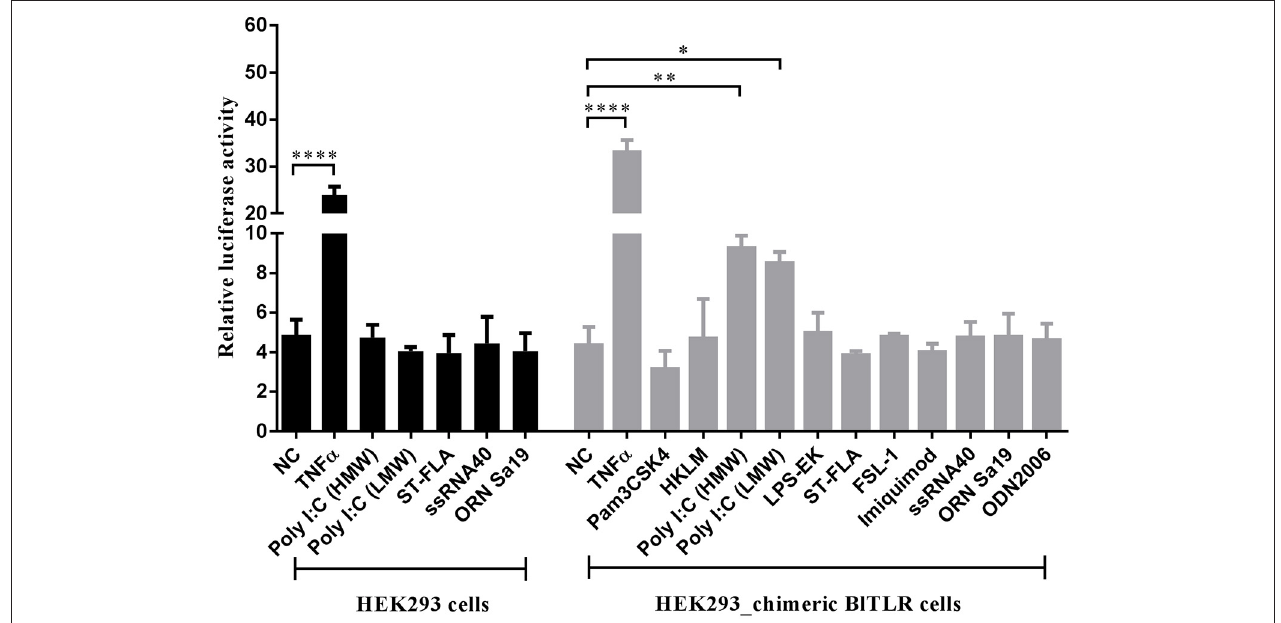
FIGURE 6 | HEK293 cells expressing chimeric BlTLR induce the activation of NF- κ B in response to Poly I:C. HEK293 chimeric BlTLR stable cells were treated with 11 different ligands (gray columns). Non-transfected HEK293 cells were treated with five potential ligands (black columns). Non-treated cells (NC) and cells treated with human TNF α (20ng/ml) were used as negative and positive controls, respectively. The luciferase activity was expressed as the ratio of NF- κ B-dependent firefly luciferase activity divided by Renilla luciferase activity. Bars represented mean ± S.D. Significant differences of mean values were analyzed according to one-way ANOVA followed by Tukey’s test. * P < 0.05; ** P < 0.01; **** P <